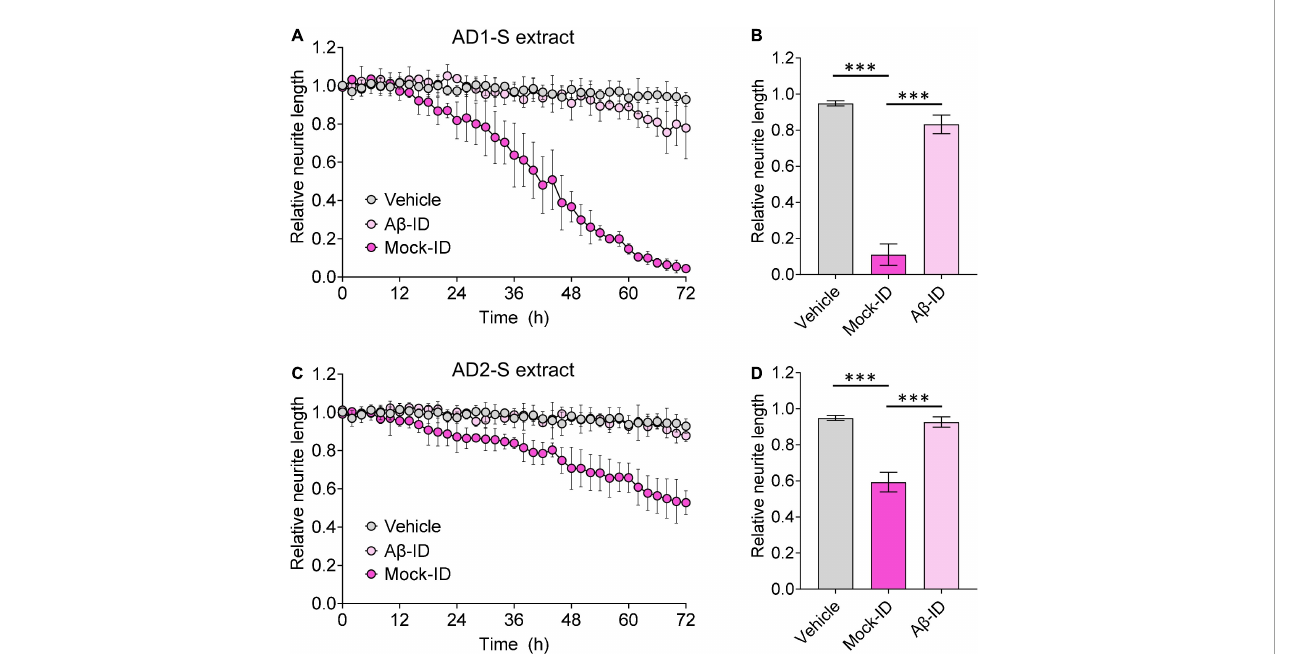
FIGURE4 Aqueous AD brain extracts impairs neuritic integrity of iNs in a manner that requires A β . Mock-ID’d and A β -ID’d S extracts of two AD brains were used to treat iNs at dilution of 1:4, and cells imaged using IncuCyte live-cell imaging instrument for 72 h. NeuroTrack-identified neurite length was measured and normalized to baseline (6 h recordings prior to sample addition) at each interval after addition of sample. (A,C) Time-course plots show that Mock-ID’d S extracts from 2 AD brains cause neurotoxicity compared to vehicle. (B,D) Histogram plots of normalized neurite length (mean values ± SD) are derived from the last 6 h of the traces shown in panels (A,C) . Treatments were examined by one-way ANOVA and significant differences are denoted as ∗∗∗ p < 0.001. Panel (B) is a reproduction of a figure previously published in Brinkmalm et al.